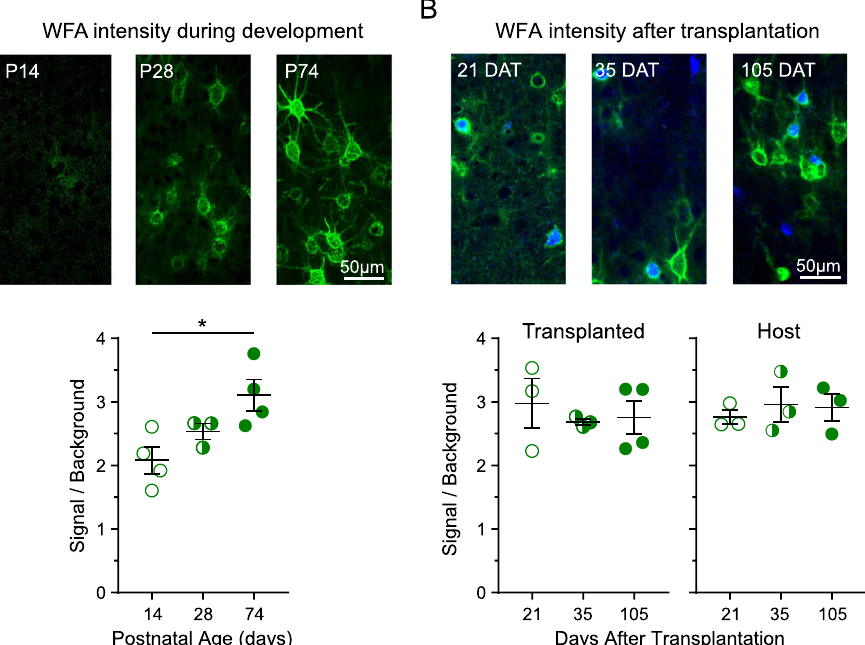
Figure 4. WFA staining intensity of PNNs surrounding host and transplanted cells does not depend on transplanted cell age. Quantification of WFA staining intensity of PNNs around PV cell bodies. The intensity of WFA fluorescence around the PV cell body (5 pixel thick region of interest) was normalized to the background by dividing its value by the staining intensity of an adjacent, unstained region. ( A ) Example sections stained with WFA at three ages spanning development (top). The signal to background ratio (bottom) increases during postnatal development (P14 = 2.08 ± 0.21 (open), P28 = 2.54 ± 0.13 (half-filled), P74 = 3.11 ± 0.25 (filled)). ( B ) Example sections of transplanted and host cells surrounded co-labeled with WFA 21, 35, and 105 DAT (top). The WFA signal to background ratio for transplanted cells (bottom left) was similar at the three timepoints assessed (21 DAT = 2.98 ± 0.39 (open), 35 DAT = 2.69 ± 0.05 (half-filled), 105 DAT = 2.76 ± 0.26 (filled)). Transplantation did not alter host WFA signal to background ratio (bottom right; 21 DAT = 2.76 ± 0.11 (open), 35 DAT = 2.96 ± 0.27 (half-filled), 105 DAT = 2.91 ± 0.22 (filled)). Normal cell development: n P14 = 40 cells, 8 sections, n = 4 mice; n P28 = 165 cells, 11 sections, 3 mice; n P74 = 13 cells, 4 mice. Transplanted neurons: n 21DAT = 48 cells, 6 sections, n = 4 mice; n 35DAT = 43 cells, 7 sections, 3 mice; n 105DAT = 78 cells, 6 sections, 4 mice. Host neurons: n 21DAT = 47 cells, 6 sections, n = 3 mice; n 35DAT = 54 cells, 7 sections, 3 mice; n 105DAT = 81 cells, 6 sections, 3 mice. Error bars represent